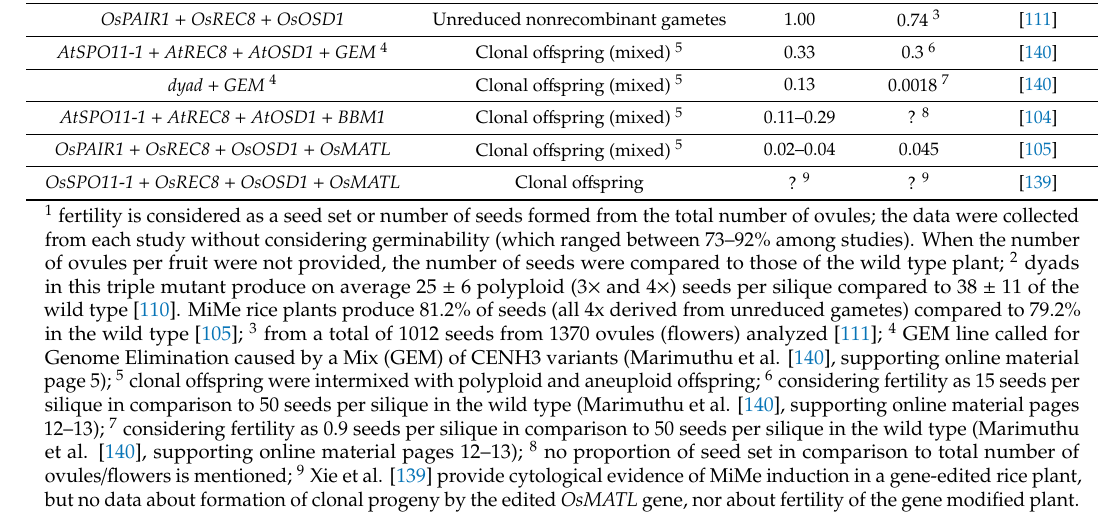
Table 2. Combination of mutants used to create unreduced nonrecombinant gametes and clonal progeny. Gene Combination Reproductive Phenotype Expressivity Fertility 1 Reference AtSPO11 - 1 + AtREC8 + AtOSD1 Unreduced nonrecombinant gametes 1.00 0.66 2 OsPAIR1 + OsREC8 + OsOSD1 Unreduced nonrecombinant